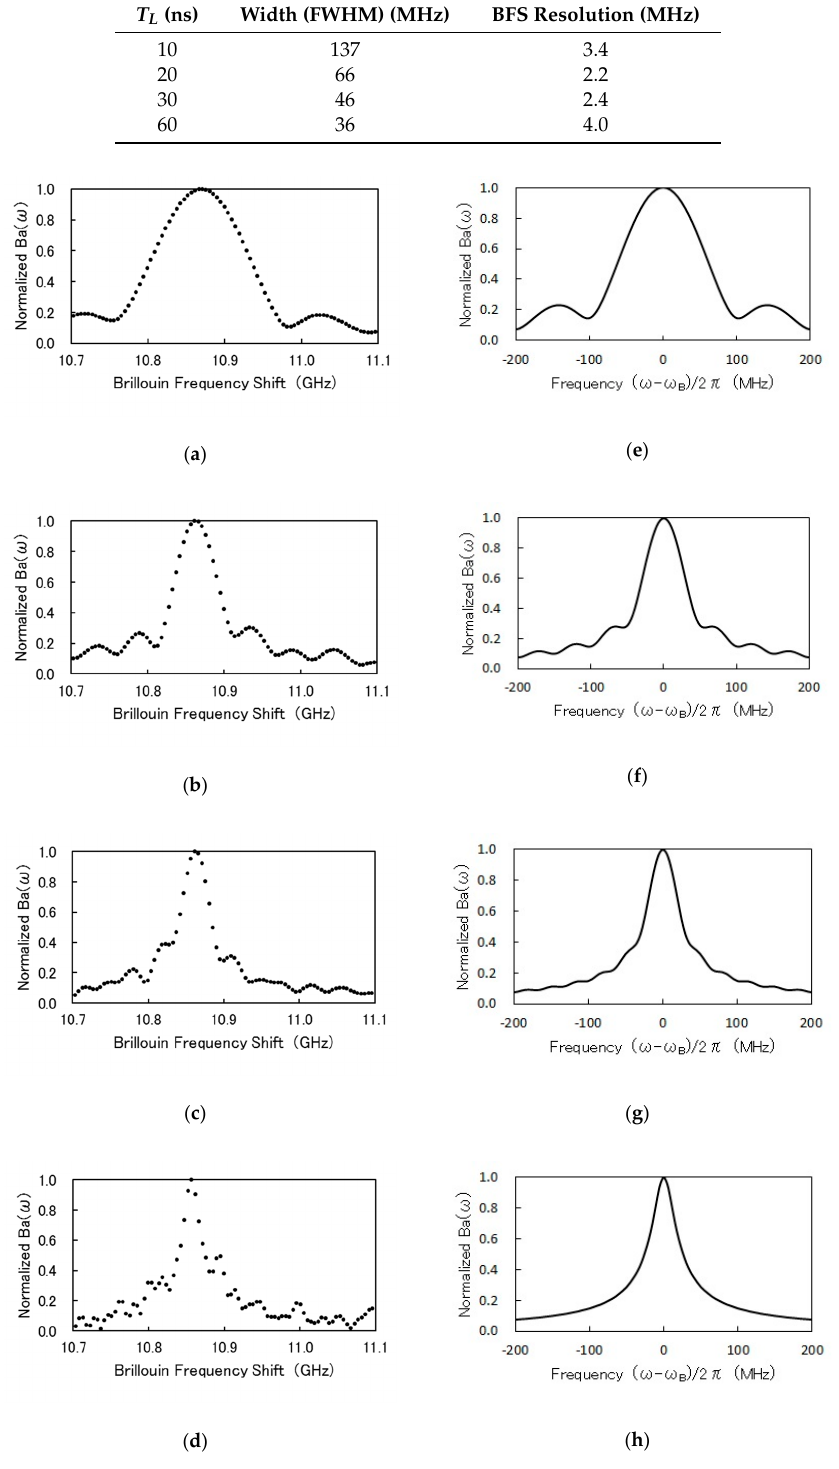
Figure 4. B a ( ω ) for various durations of T L : T S = 2 ns and T I = 0.5 ns; ( a – d ): experiments; Figure 4. 𝐵 (cid:3028) (cid:4666)𝜔(cid:4667) for various durations of 𝑇 (cid:3013) : 𝑇 (cid:3020) = 2 ns and 𝑇 (cid:3010) = 0.5 ns; (a)–(d): experiments; (e)–(h): ( e – h ): calculations; T L = 10 ns for ( a , e ); T L = 20 ns for ( b , f ); T L = 30 ns for ( c , g ); T L = 60 ns for ( d , h calculations; 𝑇 (cid:3013) = 10 ns for (a), (e); 𝑇 (cid:3013) = 20 ns for (b), (f); 𝑇 (cid:3013) = 30 ns for (c), (g); 𝑇 (cid:3013) = 60 ns for (d), (h).